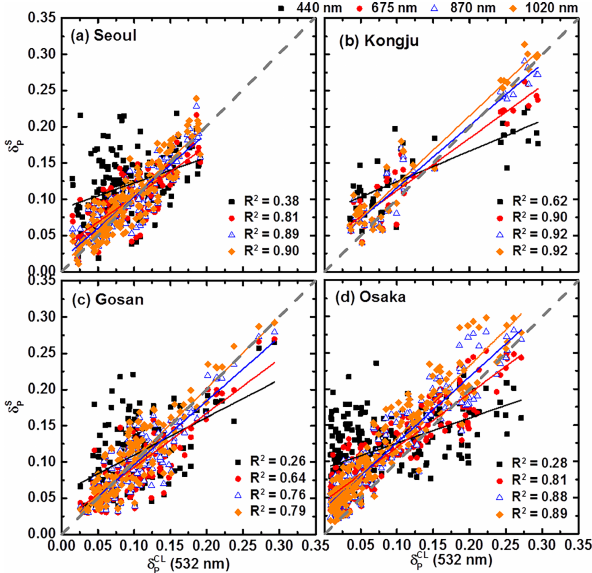
Figure 4. The correlation coefficients R 2 (the coefficient of de- termination) between δ CL at 532 and δ S at 440 (black squares), P P 675 (red circles), 870 (blue open triangles), and 1020nm (orange diamonds) at (a) Seoul, (b) Kongju, (c) Gosan, and (d)